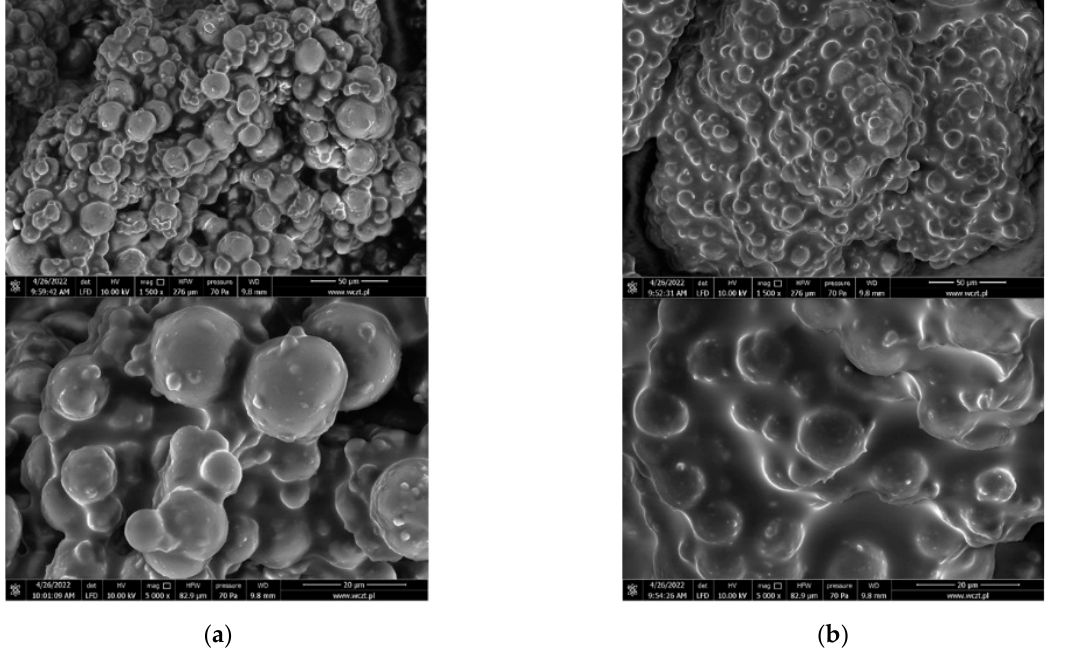
Figure 11. Scanning electron micrographs of gelatin capsules with different gemini surfactants. ( a ) Ge@12(E)-O-12(E) Br; ( b ) Ge@12(E)-O-12(E) Cl.